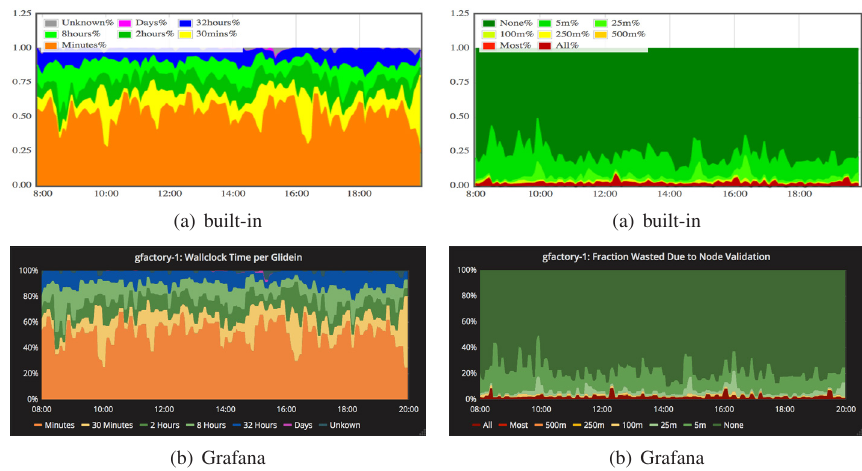
Figure 3. Comparison of pilot walltime at a particular factory from built-in GlideinWMS vs new Grafana monitoring